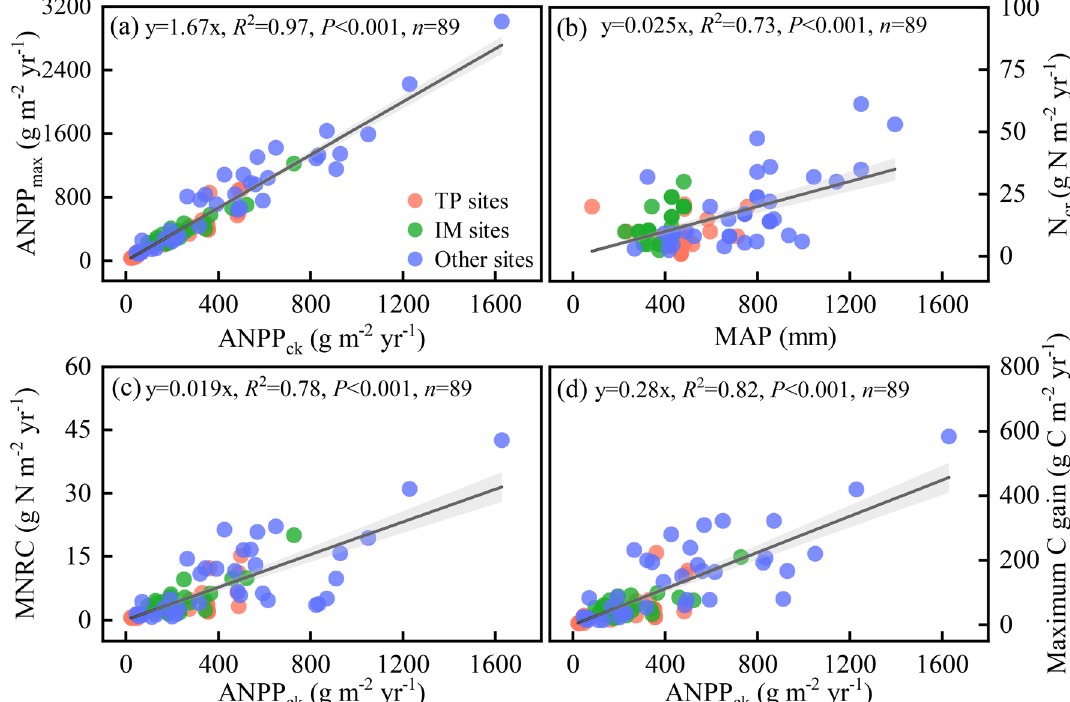
Figure 3. The relationship between the ( a ) maximum aboveground net primary productivity (ANPP max ) and initial aboveground net primary productivity (ANPP ck ), ( b ) critical N rate (N cr ) and mean annual precipitation (MAP), ( c ) maximum N retention capacity (MNRC) and ANPP ck , and ( d ) maximum N-induced C gain and ANPP ck . The red points represent Tibetan Plateau (TP) sampling plots, green points represent Inner Mongolia (IM) sampling plots, and blue points represent other global grassland sampling plots. Simple regression analyses (Pearson) were implemented. Full regression results are shown in Appendix S2: Table S4. The gray areas indicate the 95% confidence